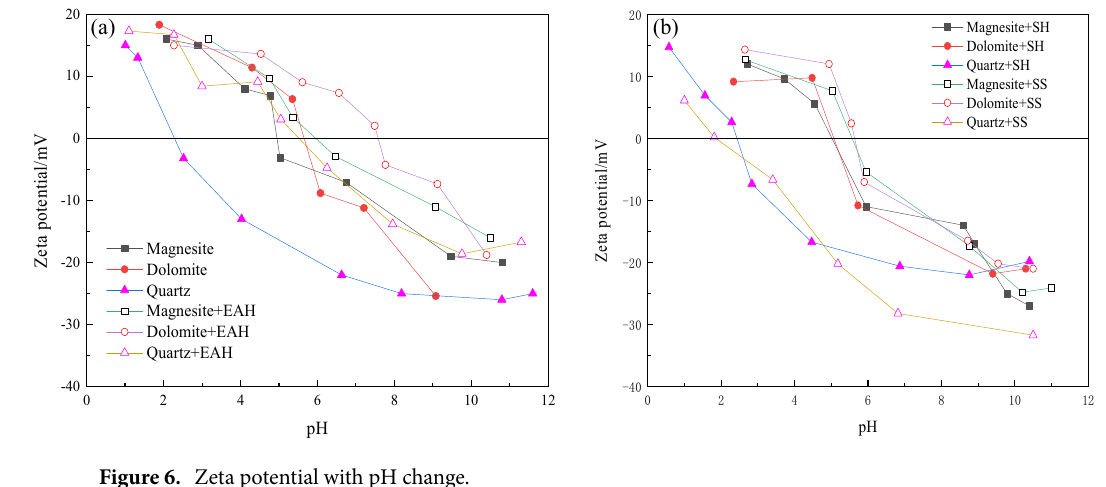
Figure 6. Zeta potential with pH